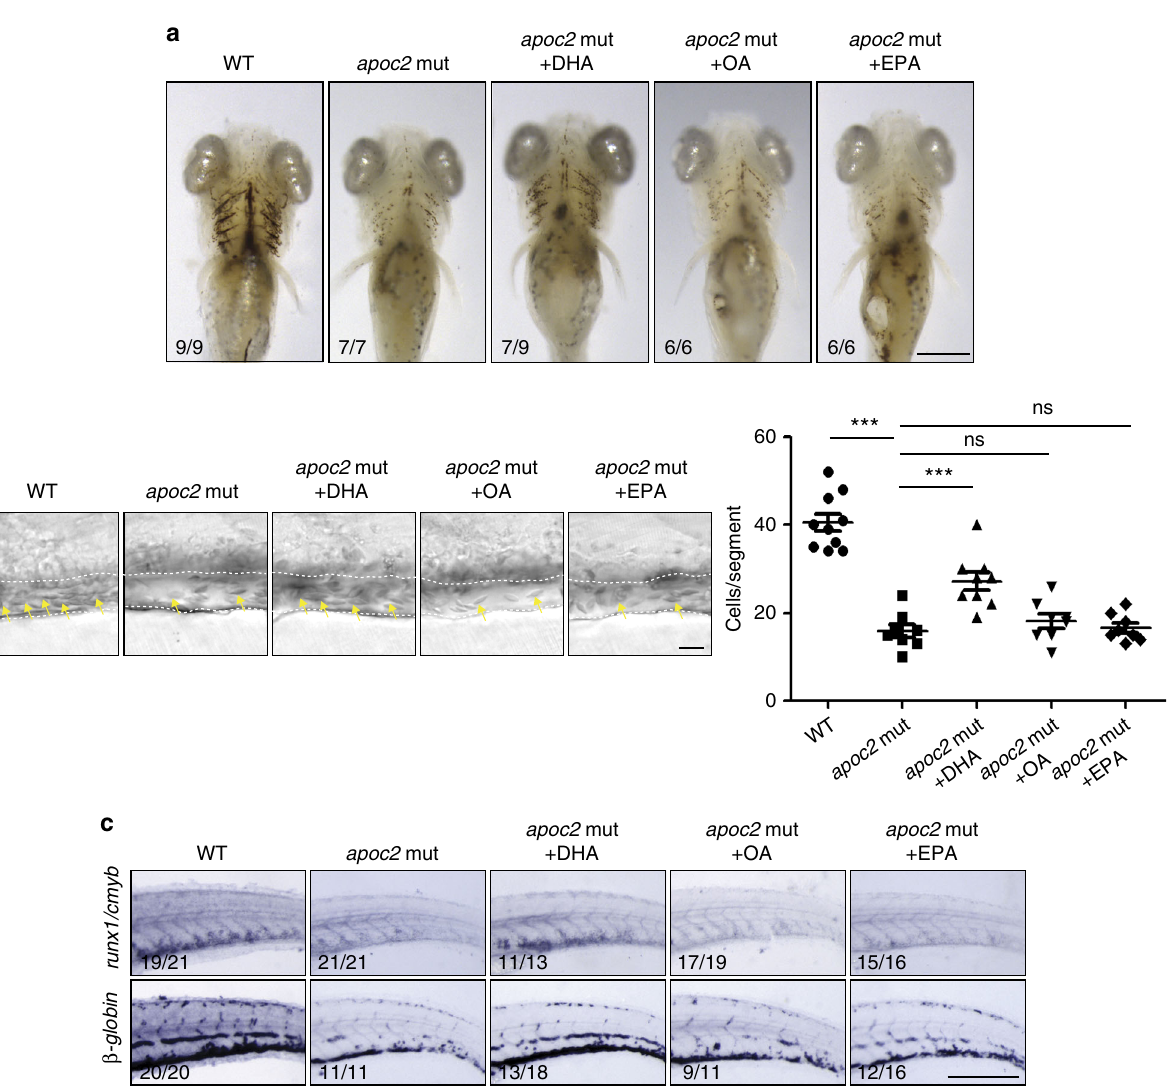
Fig. 7 DHA rescues hematopoiesis in apoc2 mutants. a – c apoc2 mutant embryos were injected with free fatty acid docosahexaenoic acid (DHA), oleic acid (OA), or eicosapentaenoic acid (EPA) at 48 hpf. a o-Dianisine staining of 6.3 dpf larvae. b Representative bright fi eld images and quantitative results of blood cell (yellow arrows) count in the caudal vein (outlined with white dashed lines) at 6.3 dpf. Mean± SEM; n = 10 (WT), n = 8 ( apoc2 mut, apoc2 mut + OA, and apoc2 mut + EPA), and n = 9 ( apoc2 mut + DHA). *** P < 0.001 (Student ’ s t test). c In situ hybridization with cmyb/runx1 and β -globin probes. Scale bars, 100 μ m in a ; 50 μ m in b ; and 200 μ m in